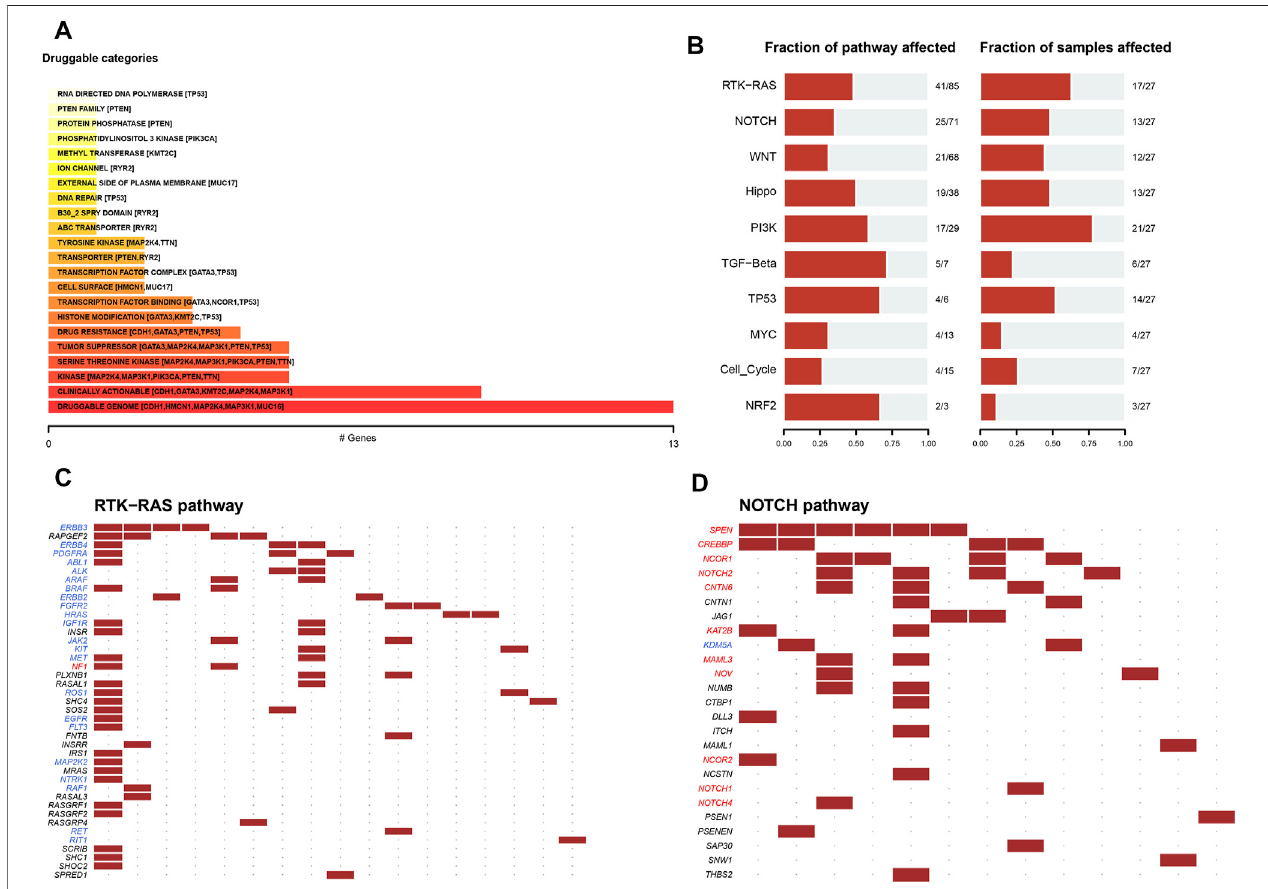
FIGURE 4 | Drug sensitivity analysis of MDN1 gene mutations. (A) Overall analysis of the relationship between gene mutation levels and gene druggability information compiled from the drug-gene interaction database; (B) Analysis of the changes in gene mutation levels in different oncogenic signaling pathways in TCGA-BRCA dataset; (C,D) Distribution of gene mutations in the RTK-Ras and NOTCH signaling pathways in patients of TCGA-BRCA dataset.